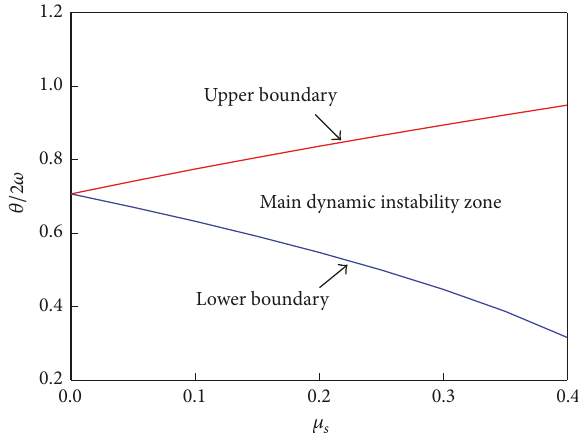
Figure 11: The main dynamic instability zone of layer-crack plate